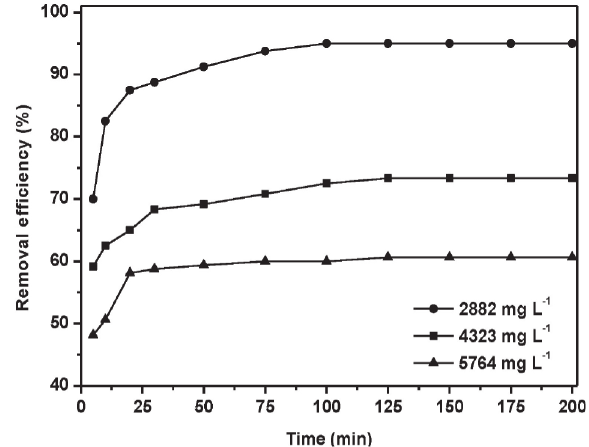
nanoparticles, (b) acrylic acid, and (c) 2 nanoparticles 2